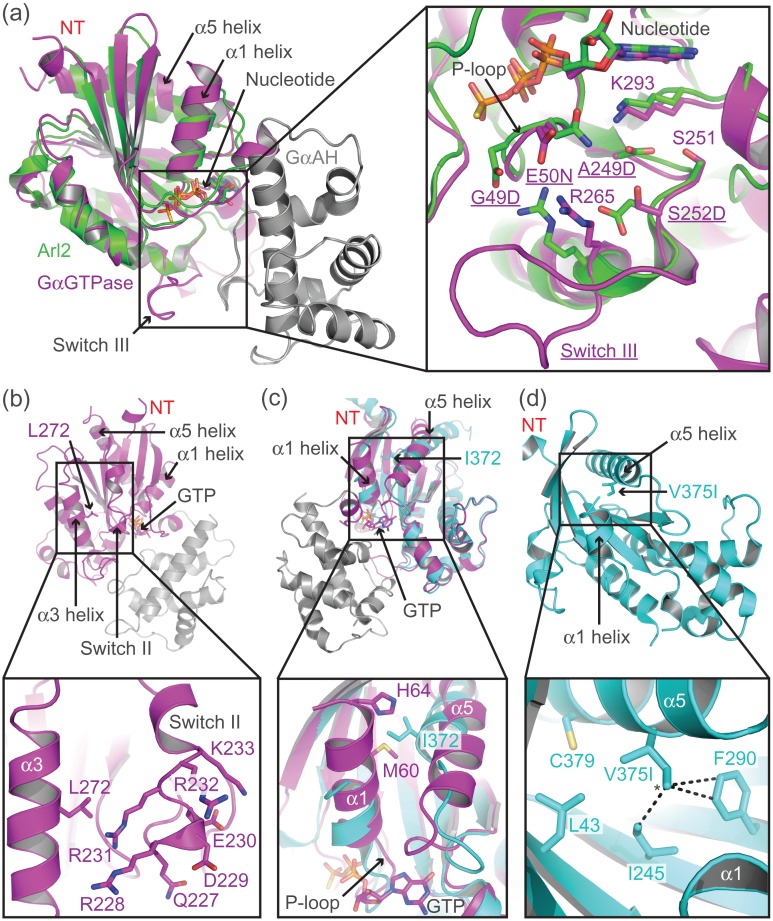
Rational design of mutations to stabilise mini-Gs. (a) Structural alignment of Gαs (PDB code 1AZT; Sunahara et al., 1997), coloured magenta and grey, and Arl2 (PDB code 1KSH; Hanzal-Bayer et al., 2002), coloured green. The Gαs GTPase domain aligns to Arl2 with an RMSD of 1.9 Å, despite sharing sequence identity of only 25%, determined using the Dali server (Holm and Rosenstrom, 2010). See Supplementary Fig. S4 for a sequence alignment between Gαs and Arl-2. The inset shows an expanded view of mini-Gs residues (shown as sticks and underlined name) that were mutated (G49D, E50N, A249D, and S252D) to match the corresponding residue in Arl2. Residues with which the mutations potentially interact are shown as sticks. (b) Mutation of Leu272, which is located within the α3 helix of Gαs (PDB code 1AZT; Sunahara et al., 1997), to aspartic acid allows potential interactions with a cluster of charged and polar residues (227–233) in the N-terminal region of switch II. (c) Alignment of Gαs in its GTP-bound conformation (PDB code 1AZT; Sunahara et al., 1997), coloured magenta, and GPCR-bound conformation (PDB code 3SN6; Rasmussen et al., 2011b), coloured cyan. In the GPCR-bound conformation Ile372 (α5 helix) sterically clashes with Met60 and His64 (α1 helix), preventing close packing of the α1 helix against the core of the GαGTPase domain. (d) The V375I mutation (modelled using PyMOL) was designed to increase hydrophobic contacts between the core of the GαGTPase domain and the α5 helix in its GPCR-bound conformation (PDB code 3SN6; Rasmussen et al., 2011b). Residues that interact with Val375 are shown as sticks, additional contacts (less than 4.2 Å), which are predicted to be formed by the δ-carbon (*) of the isoleucine mutation are displayed as dashed lines.